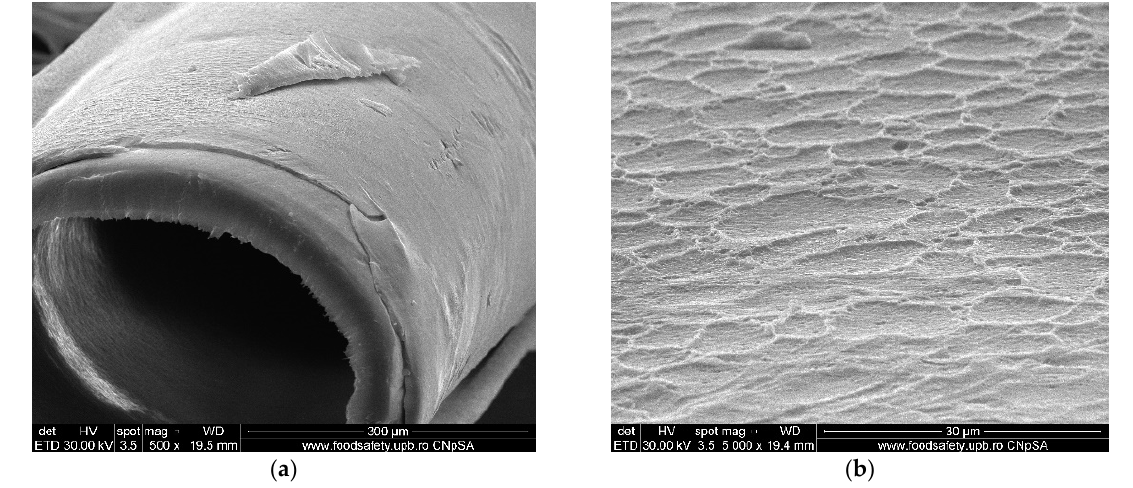
Figure 9. Morphology HEC–PPM membranes: ( a ) membrane cross–section; ( b ) membrane surface.